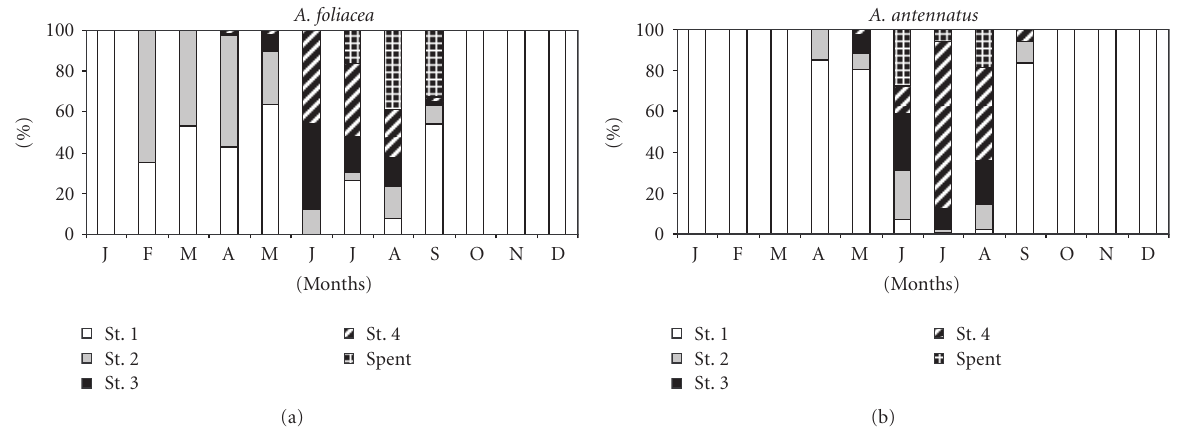
Figure 3: Monthly occurrence of ovarian maturity stages of Aristaeomorpha foliacea and Aristeus antennatus females from the eastern Ionian Sea.